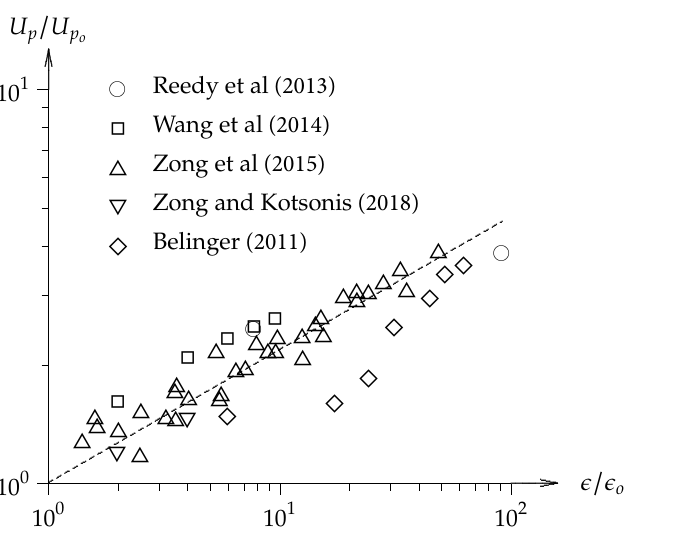
Figure 31. Peak jet velocity U p versus dimensionless energy deposition.